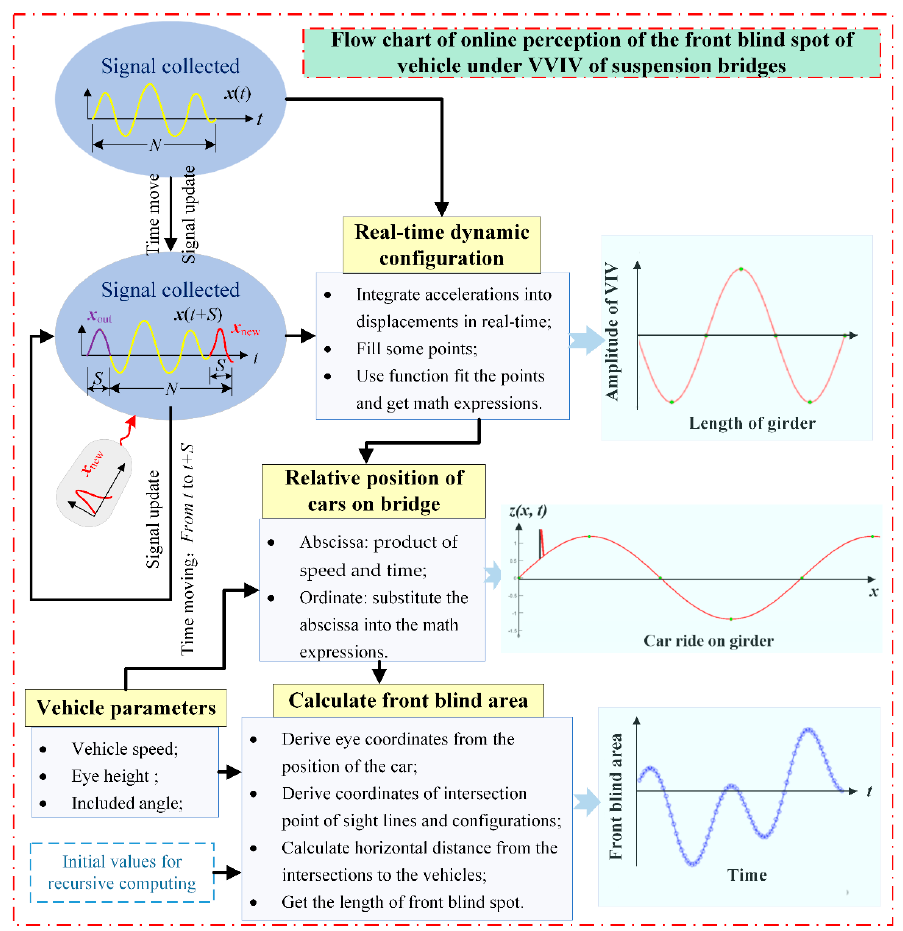
Figure 11. Flow chart of online perception of front blind area of the vehicle on suspension bridge experiencing VVIV.